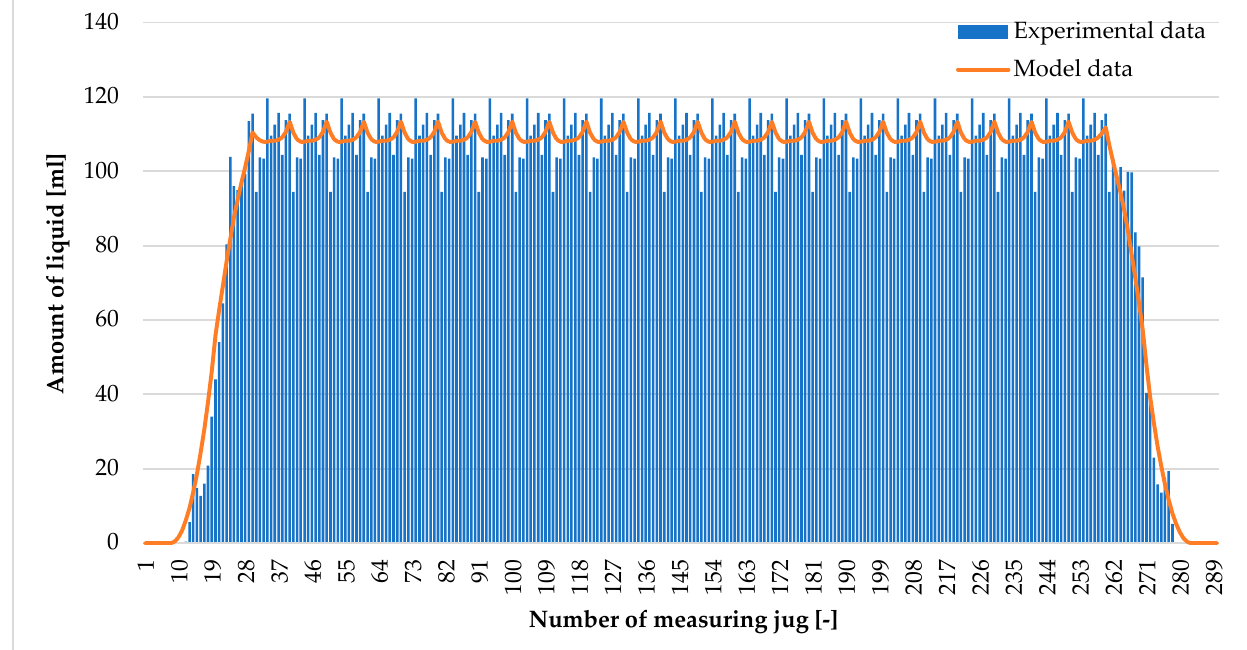
Figure 4. Spray fallout distribution for RS MM 110 03 nozzles.